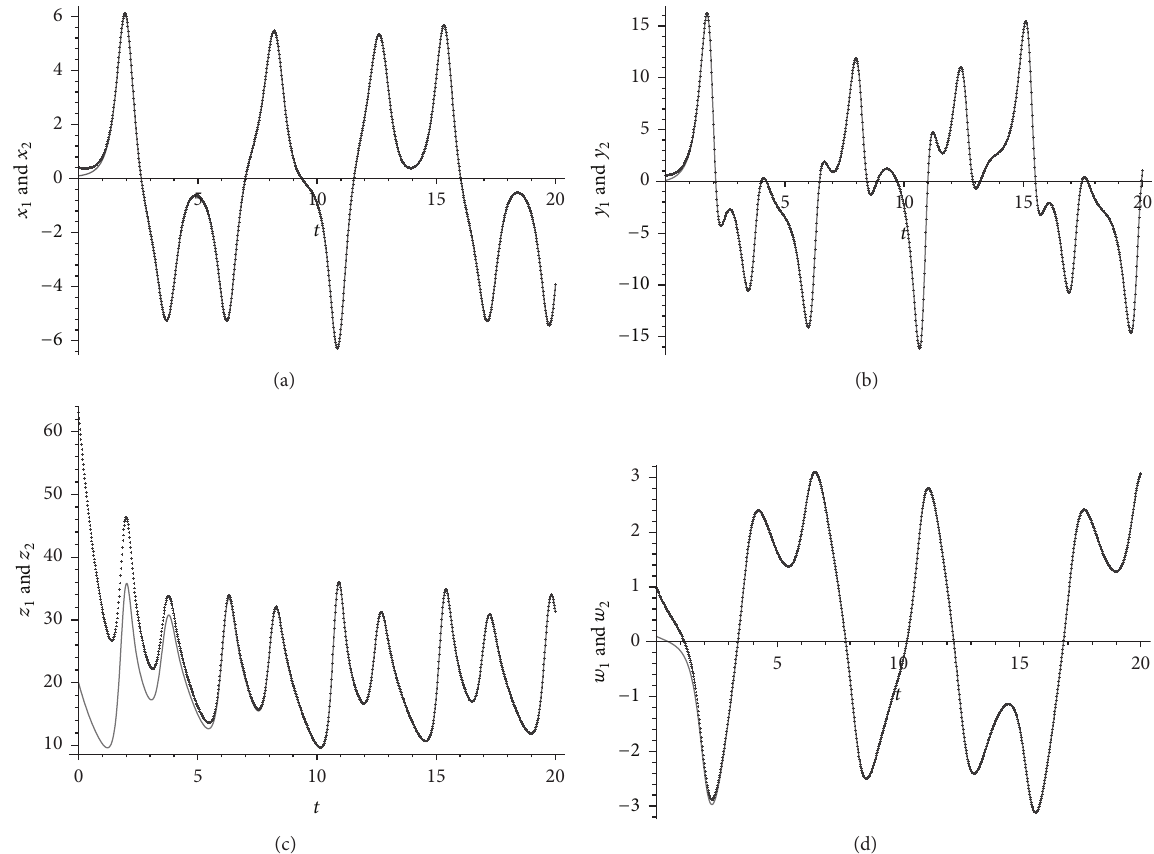
𝑦 2 (the solid line). (c) Signals